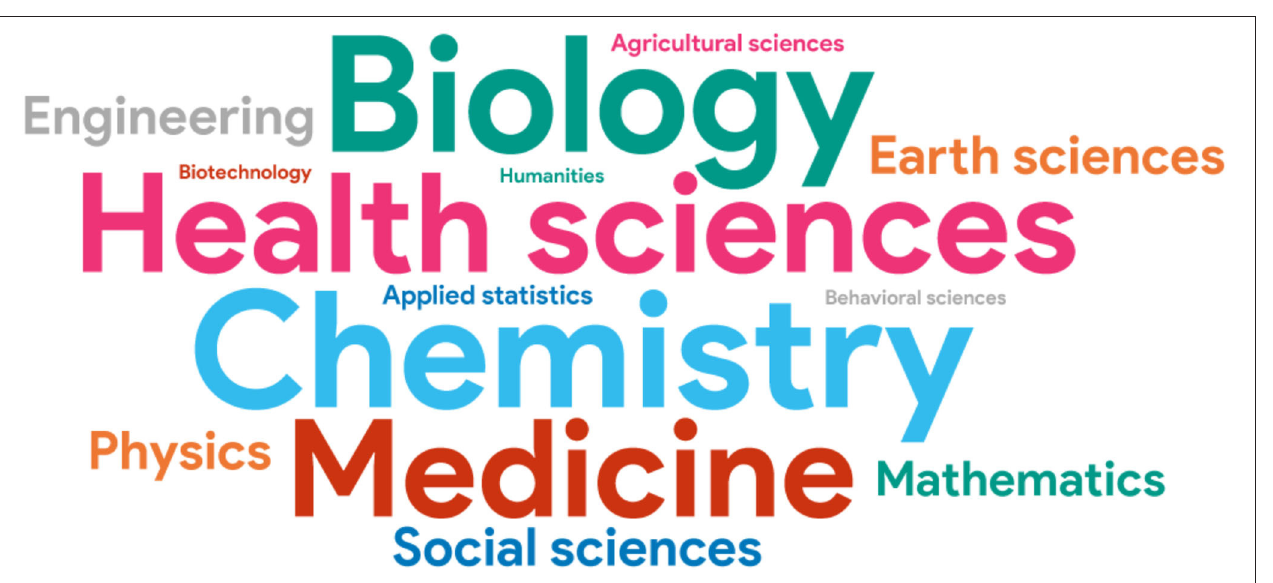
FIGURE 2 | Area of specialisation of respondents of the initial